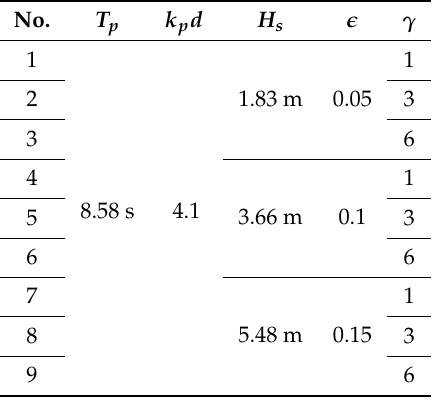
Table 1. Overview of the investigated irregular sea states No. T p k p d H s (cid:101) γ 1